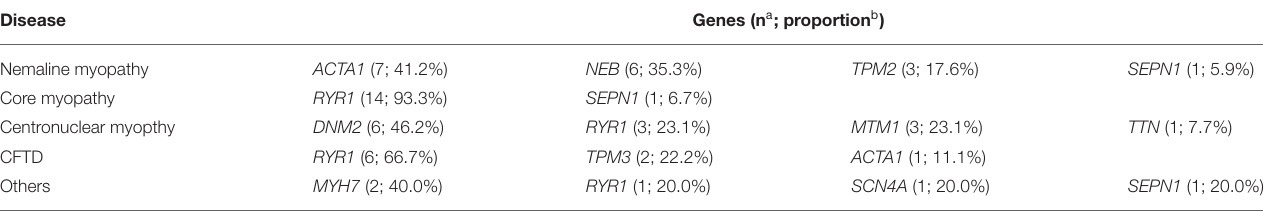
TABLE 2 | Genetic information of enrolled studies. Disease Genes (n a ; proportion b ) Nemaline